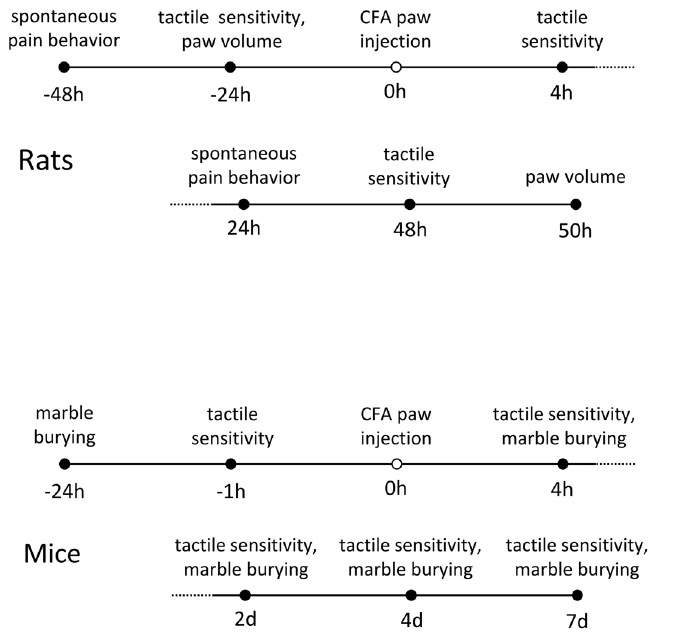
Figure 1. Timeline of experimental procedures in rats and